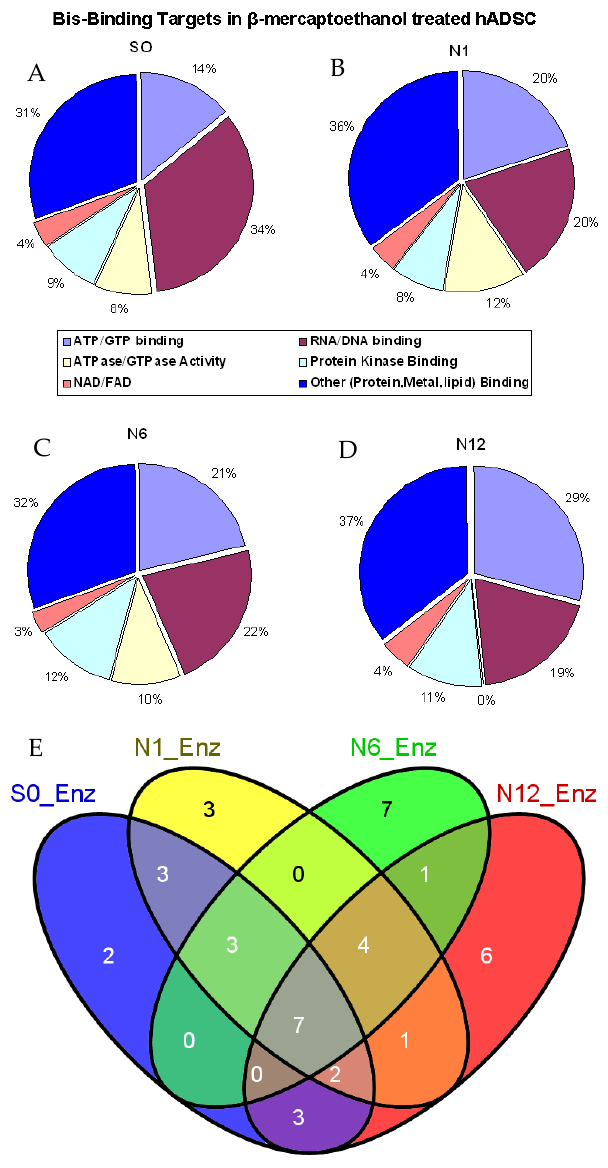
Figure 3. Bis-probe bound proteins in group clusters percentages in each sample treatment. ( A ) S0, ( B ) N1, ( C ) N6 and ( D ) N12. (E) Number of enzymes captured by the Bis-group in each treatment group.